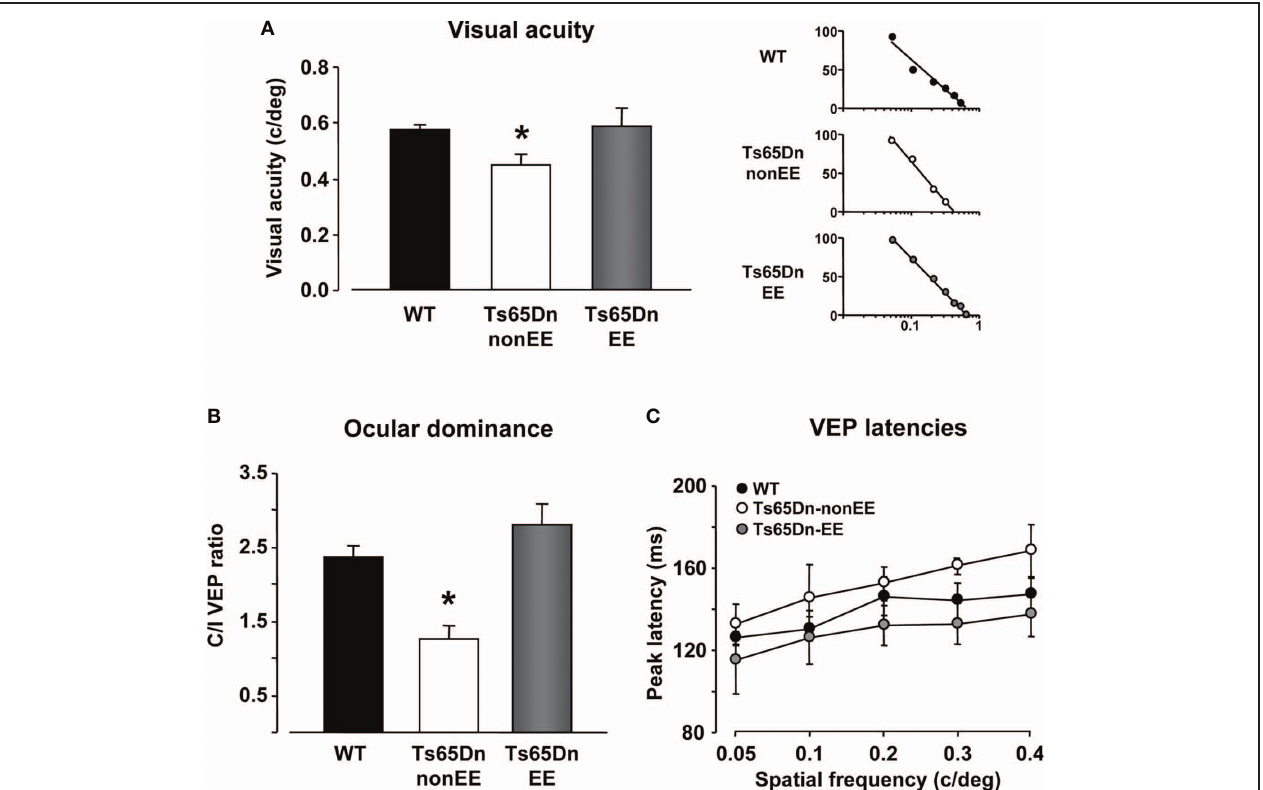
FIGURE 3 | Restoration of visual functions in Ts65Dn mice by environmental enrichment. Visual acuity (A) , ocular dominance (B) and peak latency (C) assessed by electrophysiological recordings of visual evoked potentials (VEPs) from the primary visual cortex in WT (black), Ts65Dn-non-EE, (white), and Ts65Dn-EE (gray) mice. One-Way ANOVA showed that a statistical difference in the mean values was present among the three groups for both visual acuity and C/I VEP ratio ( p < 0 . 05 and p < 0 . 001, respectively); a multiple comparison procedure (Holm–Sidak method) showed a statistical difference between WT and Ts65Dn-non-EE mice and between Ts65Dn-non-EE mice and Ts65Dn-EE mice, but not